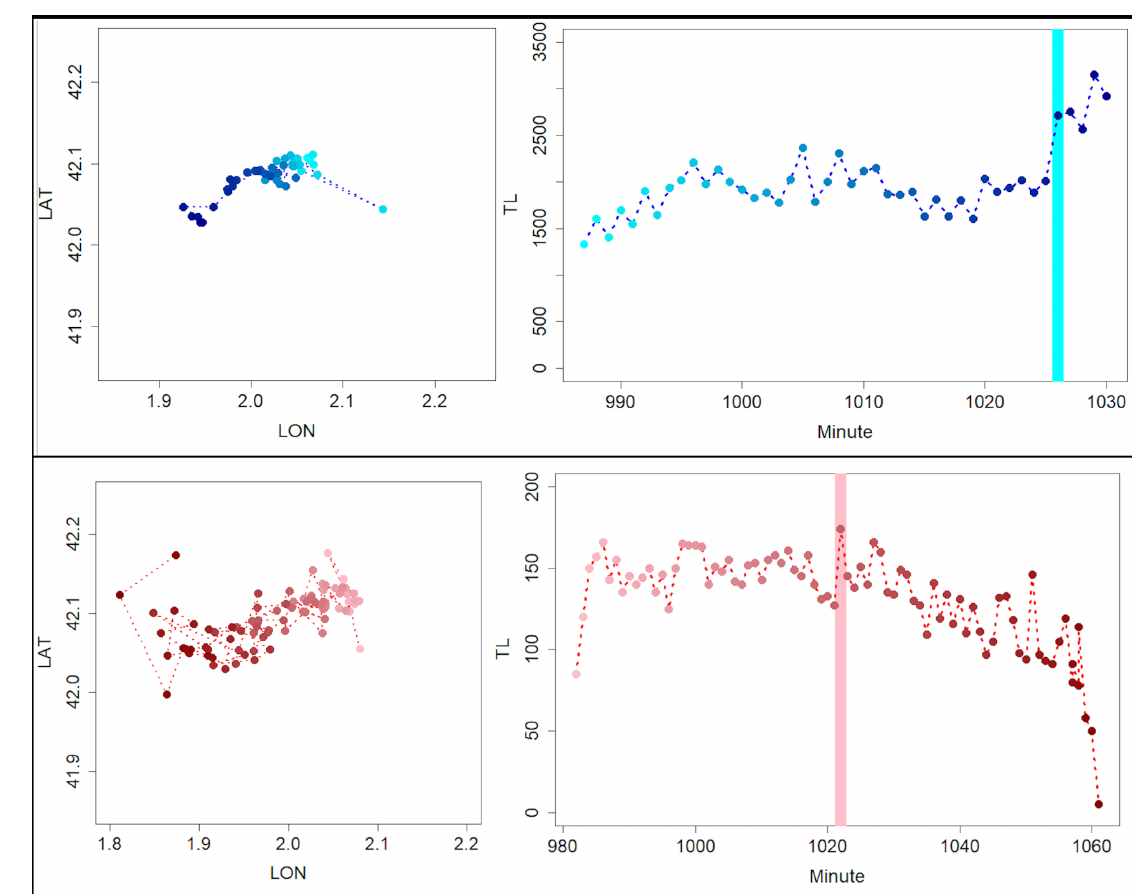
Figure 4. Examples of the partial life cycles of a thunderstorm for the Level 1 (multiple sources) centroids and lightning jump warning ( above ) and the same for single-TL sources detected, or Level 2 ( below ). Left panels correspond to the trajectories and right ones to the total lightning time evolution. The vertical shaded lines indicated the time the lightning jumps occurred. Event of 6 September